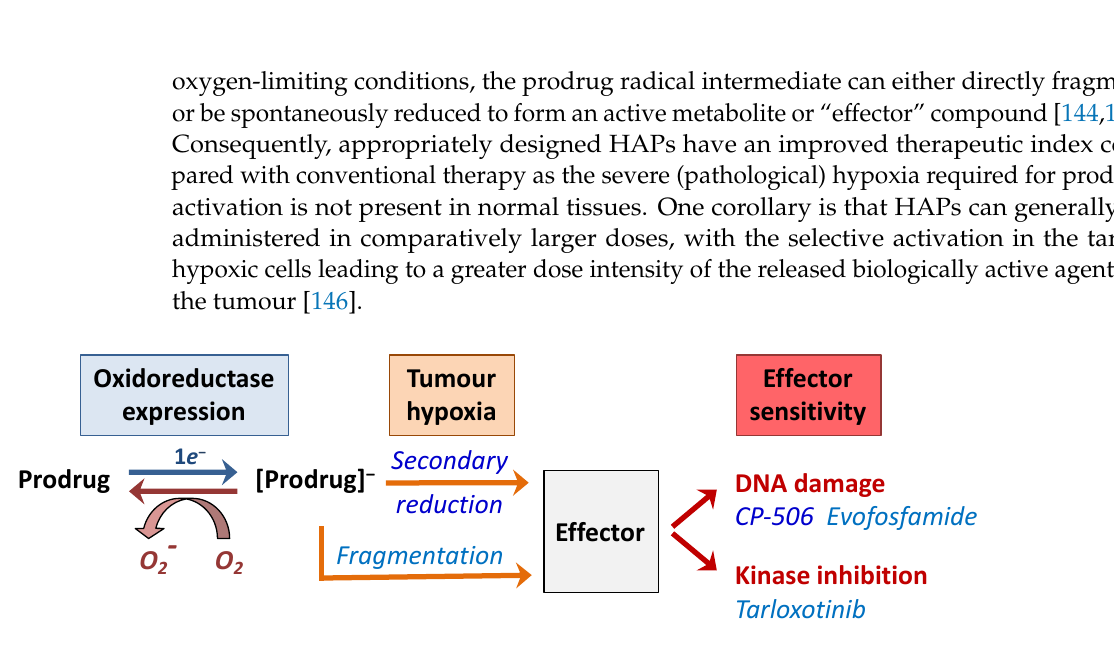
Figure 3. General mechanism of activation of a hypoxia-activated prodrug. Hypoxia-activated prodrugs are inactive under oxygenated conditions with their reduction limited by a futile redox cycle. Upon exposure to a hypoxic environment, HAPs undergo sequential reduction steps or fragments to form either a DNA damaging agent or release a kinase